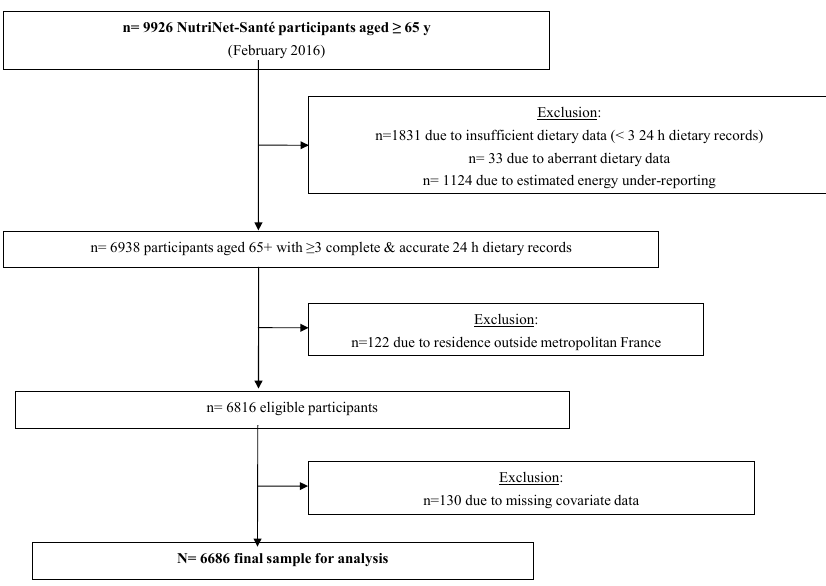
Figure 1. Participant selection flowchart.